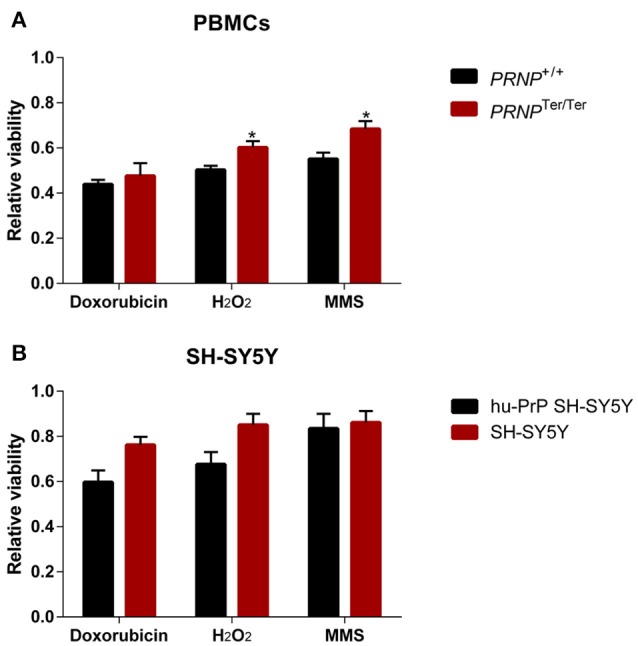
Lack of PrPC expression does not decrease cellular viability. Peripheral blood mononuclear cells (PBMCs) with and without PrPC expression, and human neuroblastoma SH-SY5Y cells with very low PrPC levels (mock-transfected) and moderate PrPC levels (stably transfected with human PrPC), were treated for 24 h with doxorubicin (PBMCs 3 μM, SH-SY5Y 2 μM) or H2O2 (PBMCs 75 μM, SH-SY5Y 150 μM), or methyl methanesulfonate (MMS) (PBMCs 0.5 mM, SH-SY5Y 1.5 mM) for 1 h, with 23 h recovery. Viability in PBMCs (n = 4) (A) and SH-SY5Y cells (n = 3) (B) (relative to controls) with and without PrPC expression after induction of cellular stress with doxorubicin, H2O2 and MMS is shown, assessed by the Alamar Blue assay using Cytation 3. Values are given as mean ± SEM. * indicates p < 0.05 (Significance tested by multiple t-test with Holm-Sidak correction).